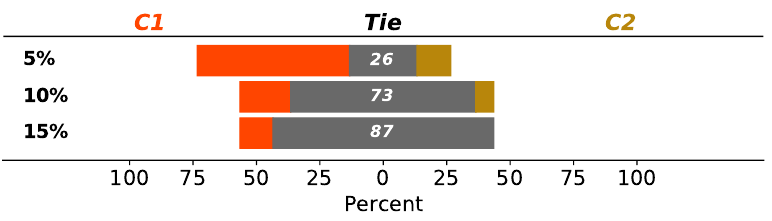
Figure 7. Differences in car comparison percentages for A v variable when several threshold values are selected in order to consider the difference between them significant.